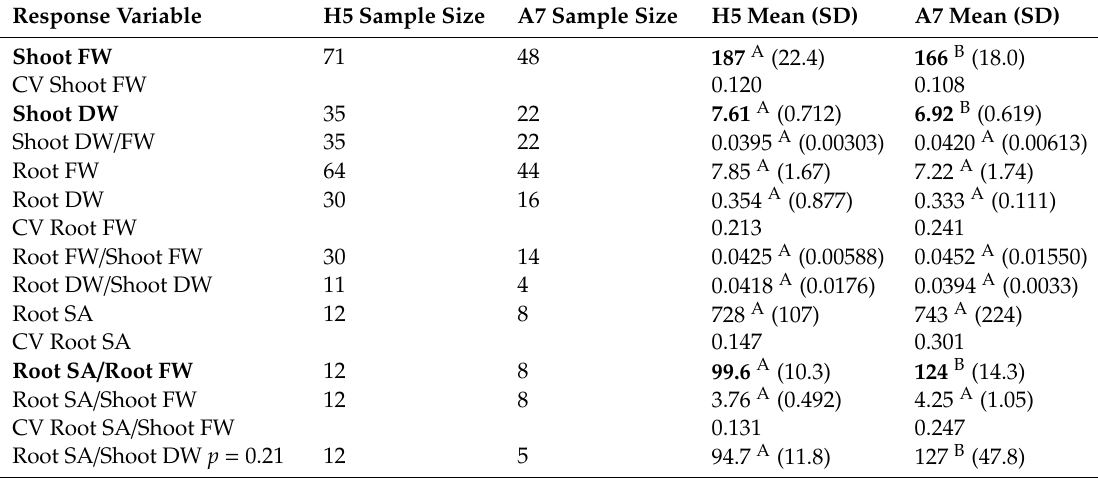
Table 1. Overall mean (SD) and treatment means (SD) for each response variable with their coe ffi cient of variations (CV = ratio of SD to mean). Root surface area is cm 2 , all weights are in grams, and di ff erent superscript letters identify significant di ff erences between treatments at α = 0.05. Average surface area and fresh weights of the lettuce root within the rockwool (not included in root measurements)